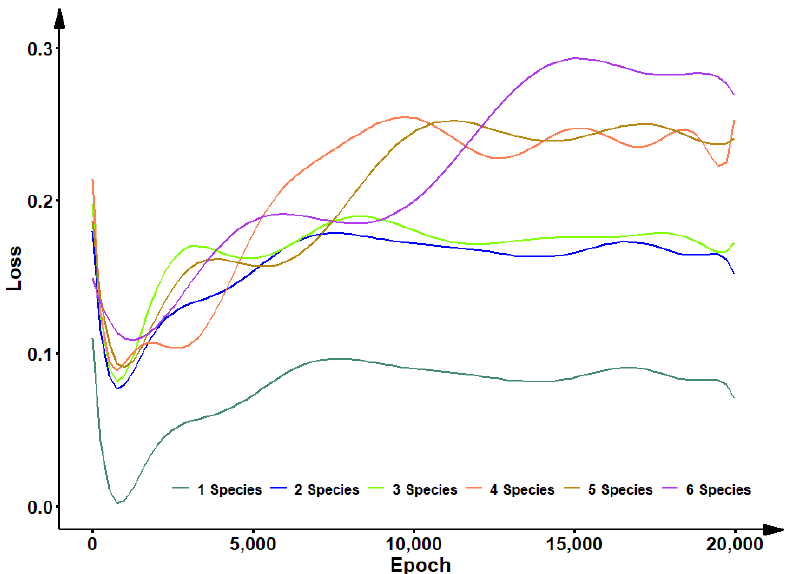
Figure 5. Variation of loss concerning epoch and number of species used in training for convolutional neural networks.